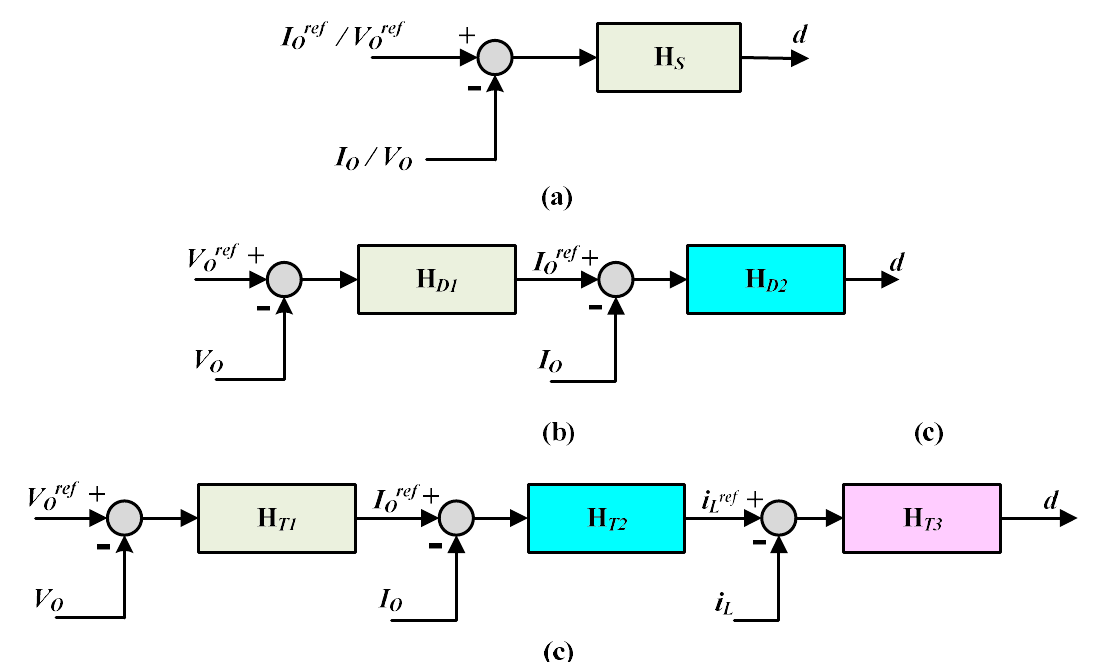
Figure 8. Controller structure: ( a ) single loop with H S regulator; ( b ) double loop with H D 1 and H D 2 are the outer and inner loop regulators respectively; and ( c ) cascaded pattern of triple-loop.